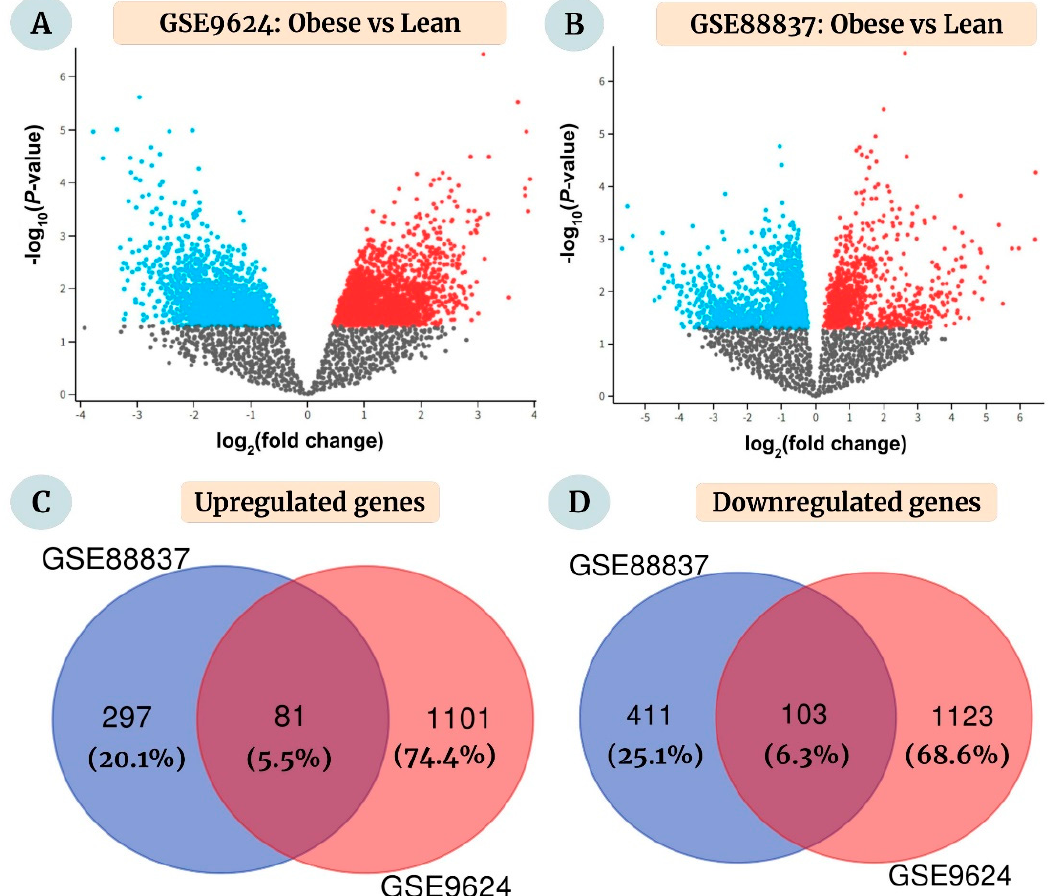
Figure 2. Volcano plots depicting the analysis of obesity-induced differentially-expressed genes (DEGs) in visceral or omental adipose tissue comparing obese and lean pediatric subjects (aged 2-19 years) in the datasets ( A ) GSE9624 and ( B ) GSE88837, respectively. The publicly available Gene Expression Omnibus (GEO) datasets, downloaded from the NCBI website, together comprised 40 samples from 19 obese and 21 lean children or adolescents. DEGs were obtained using the GEO2R online interactive tool (that uses the GEOquery, Limma, and umap R packages) with the cut-off p -value < 0.05. The downregulated and upregulated genes are depicted in blue and red, respectively, for both datasets. ( C , D ) The DEGs for the individual datasets were further segregated using the threshold |log 2 (fold change)| ≥ 1. Venn diagrams indicate the overlap between ( C ) upregulated and ( D ) downregulated DEGs, respectively. These 184 common DEGs (81 upregulated and 103 downregulated) were selected for further analysis.